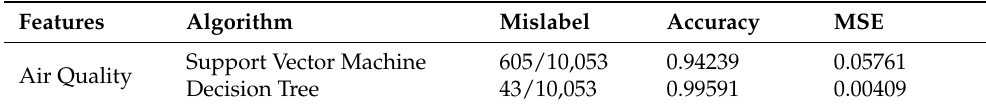
Table 3. Evaluation of air quality monitoring classification